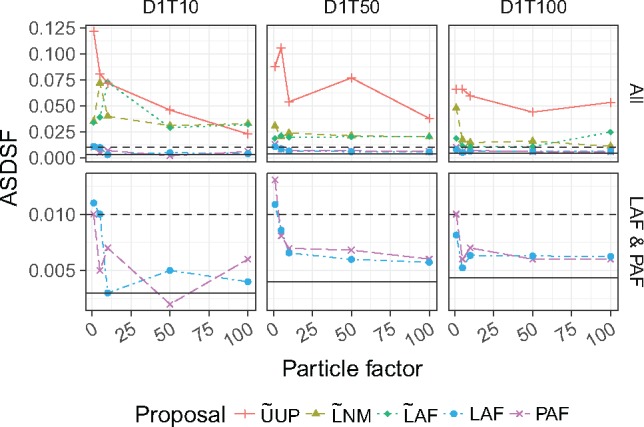
Average standard deviation of split frequencies (ASDSF) between \documentclass[12pt]{minimal}
\usepackage{amsmath}
\usepackage{wasysym}
\usepackage{amsfonts}
\usepackage{amssymb}
\usepackage{amsbsy}
\usepackage{upgreek}
\usepackage{mathrsfs}
\setlength{\oddsidemargin}{-69pt}
\begin{document}
}{}$\textsf{sts}$\end{document} and MrBayes posterior samples. These results are for the three data sets D1T10, D1T50, D1T100, and include several particle factors. The first row shows the results for every proposal while the second row only shows the LAF and PAF results. The horizontal line represents the ASDSF calculated using two chains in MrBayes. The horizontal dashed line marks 0.01, a common convergence criterion.